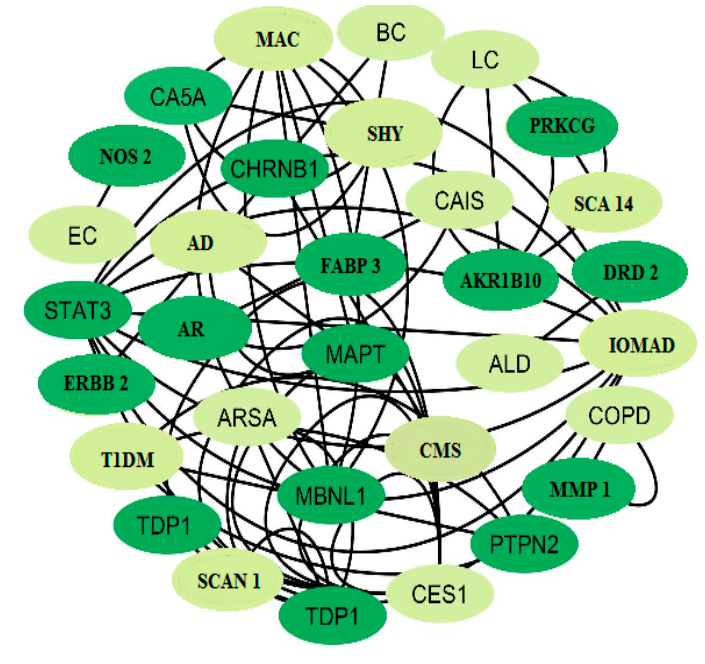
Figure 6. Target disease network (T-D-N). The dark color represents targets and the light color indicates diseases.